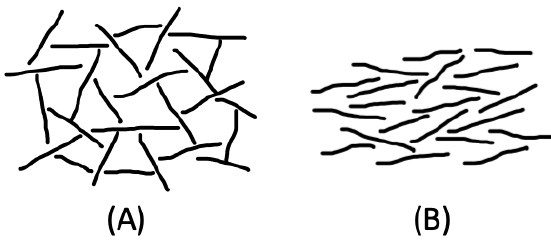
Figure 10. Scheme of collapse processes in silts: (A) Pre-collapse structure (“house of cards structure”); (B) Post-collapse